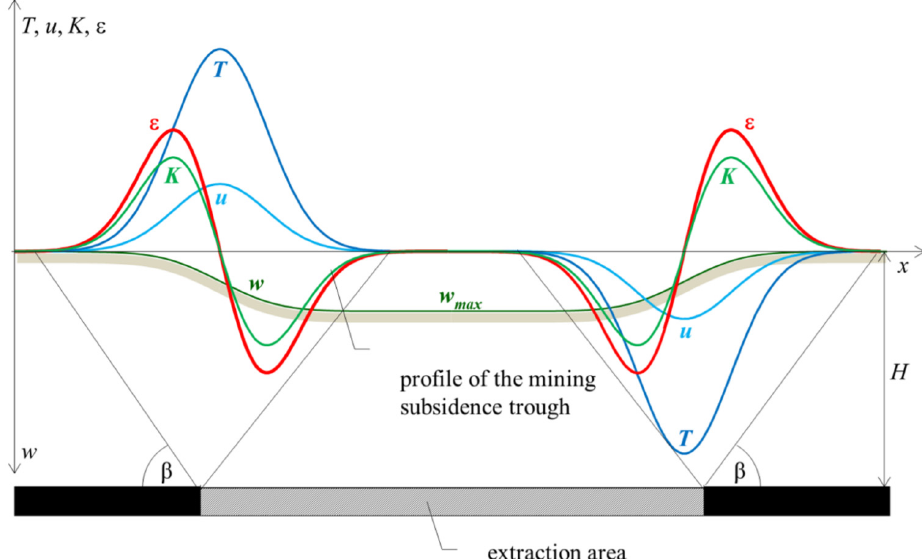
Figure 2. Distribution of surface deformation indicators over the extraction area: ( ε ) horizontal ground strain; ( u ) vertical displacement; ( T ) slope; ( K ) ground curvature; ( H ) depth of cover; ( β ) the angle of impact [29].